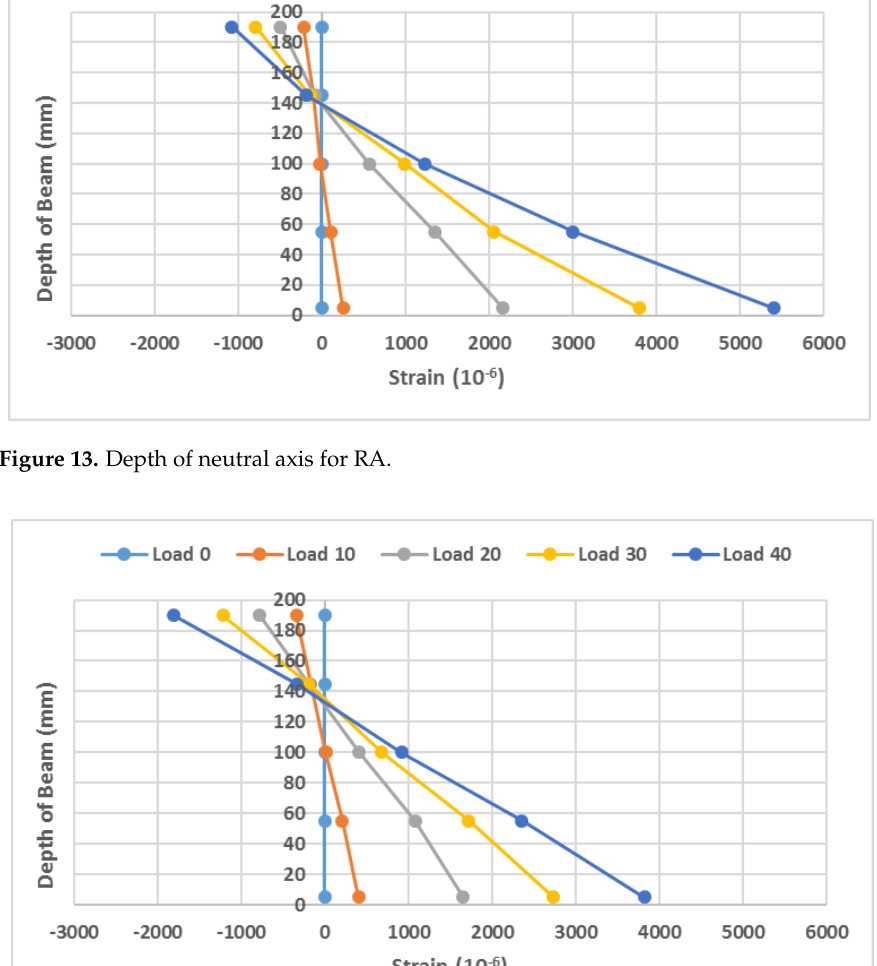
Figure 14. Depth of neutral axis for PC.